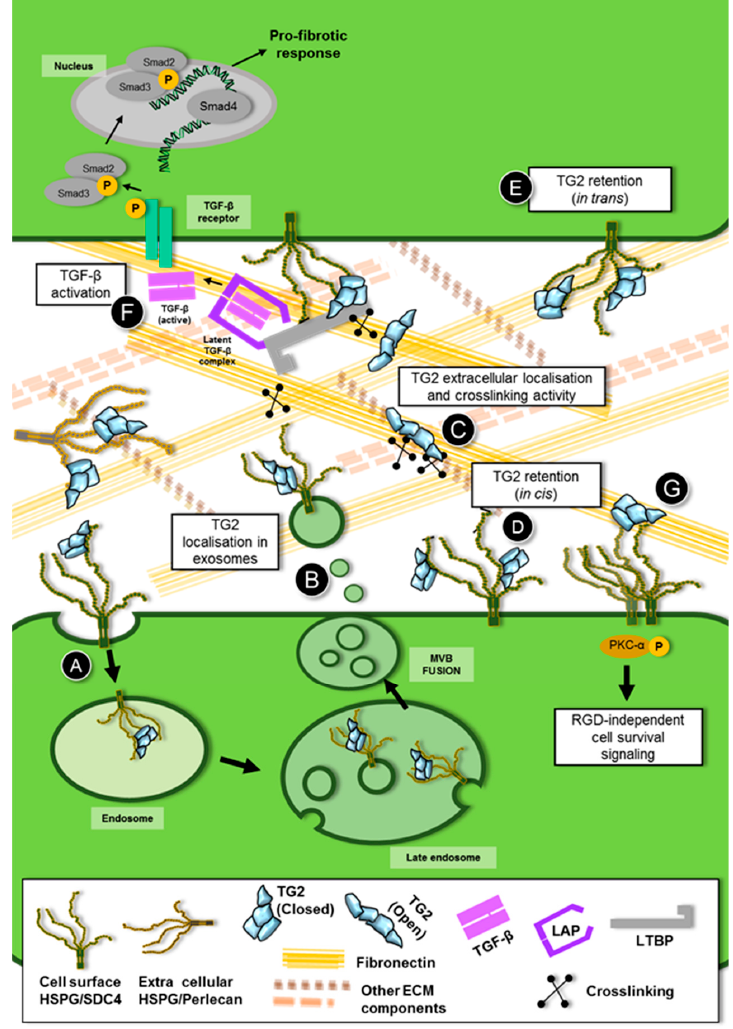
Figure 1. Interplay between transglutaminase-2 (TG2) and heparan sulfate (HS)/syndecan-4 (Sdc4). ( A ) HS/Sdc4 traps TG2 at the cell surface contributing to its extracellular accumulation. This interaction could determine endocytosis of TG2 and incorporation of TG2-HS/Sdc4 complexes in